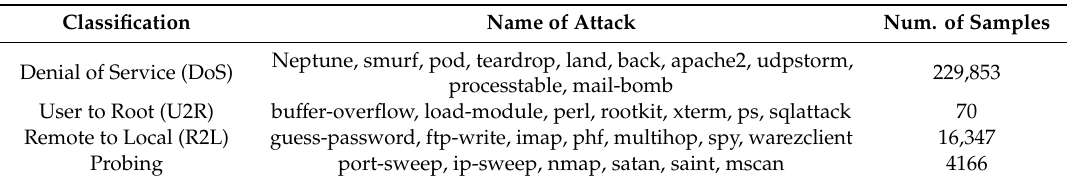
Table 1. Type of attacks in corrected